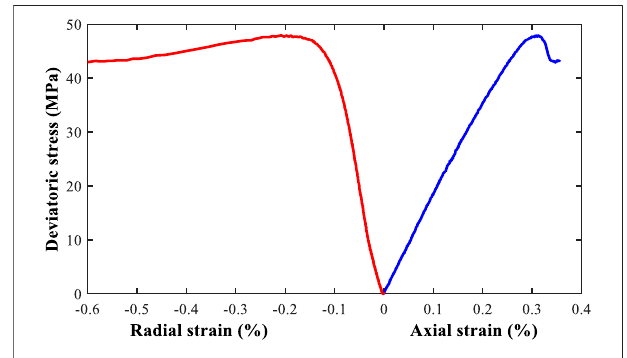
FIGURE 3 | Results of the tri-axial compression